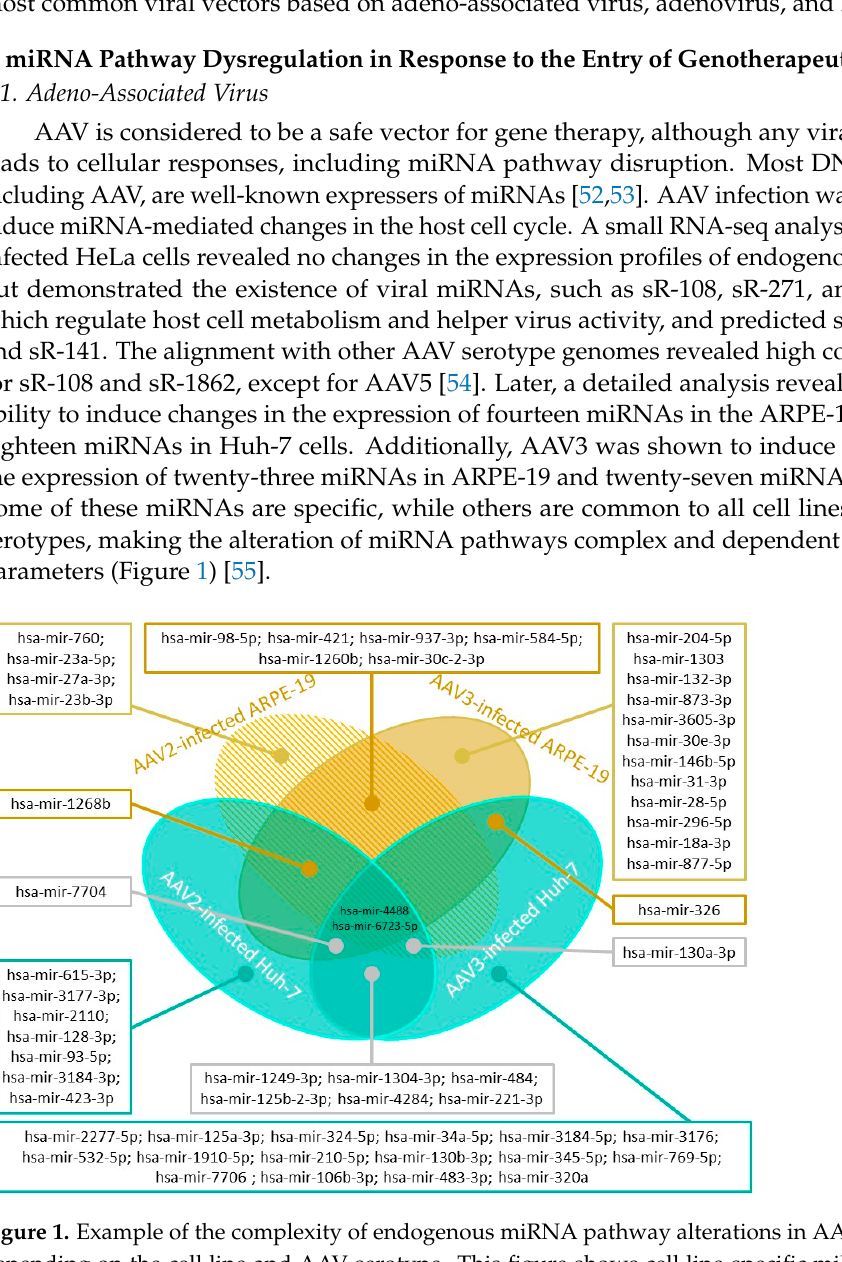
Figure 1. Example of the complexity of endogenous miRNA pathway alterations in AAV infections depending on the cell line and AAV serotype. This figure shows cell line-specific miRNAs, AAV serotype-specific miRNAs, and general miRNAs that are presented independently on the cell line and AAV serotype.